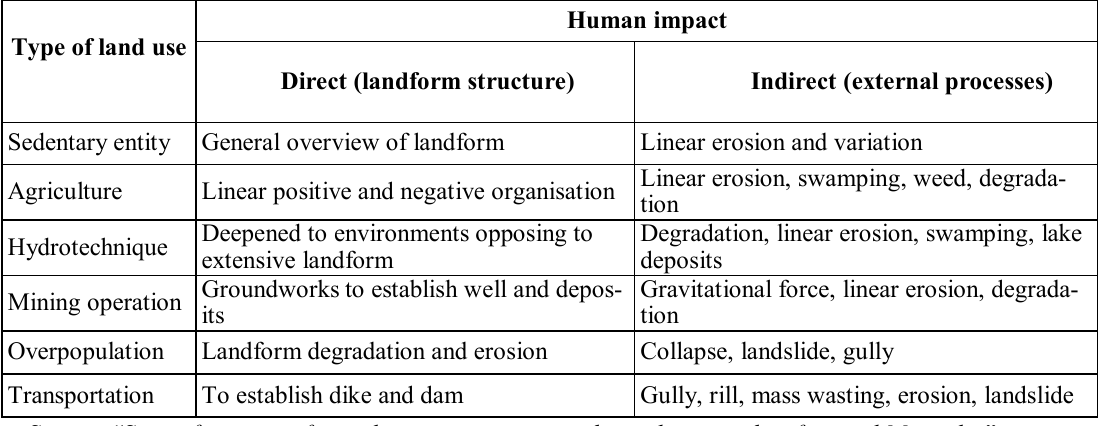
Table 1 . Human activity on landform modification